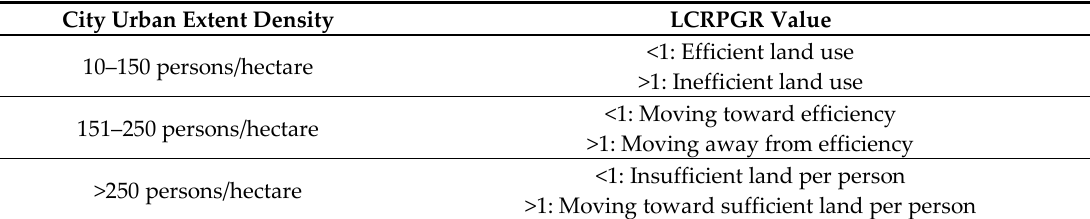
Table 2. The classification criteria proposed by